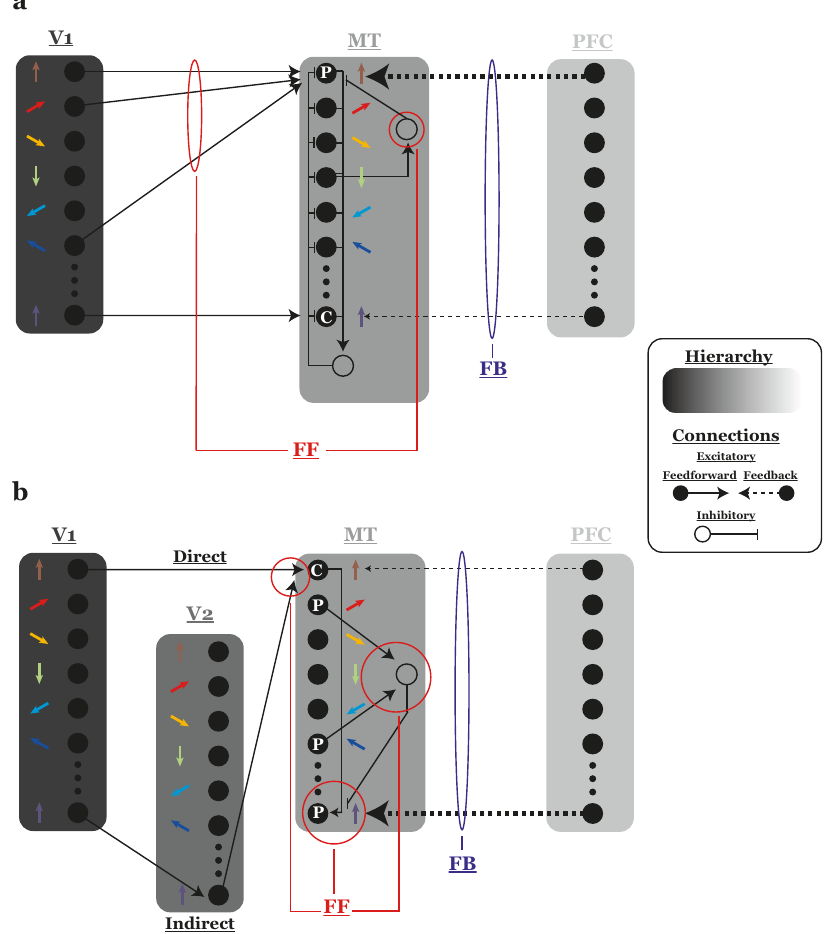
Fig. 8 | Possible circuitry underlying the relationship between pattern selec- tivity and choice probability. a A two-stage model of component- and pattern- direction selectivity and the potential in fl uence of top-down feedback on choice- relatedactivityinMT.Here,patterndirectionselectivity(PDS- “ P ” )attheMTstage arises through: (i) broad sampling over direction selective inputs consistent with a particularpatternvelocity,and(ii)strongtunedsuppression.MTstagecomponent direction selective (CDS)cells( “ C ” )sample narrowlyoverinput directionsand lack strong tuned suppression.Untuned suppression confers gain control in both populations. Colored arrows represent units ’ preferred direction. Only a subset of V1-MT connections and a single pattern- and component-direction selective unit are illustrated for clarity. In the case of a feedforward (FF) interpretation of our results, the broader input tuning and strong tuned suppression in PDS cells (highlighted inred)generates alargerdifferencein activityinresponse to patterns withmultiplemotions.Thispopulationdrivesupstreamdecisioncircuitsandbiases perception in our segmentation task. Conversely, in the feedback (FB) case,